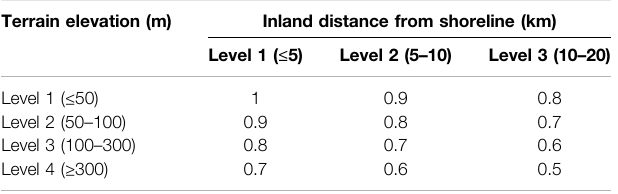
TABLE 5 | Values of the vulnerability index for the typhoon – storm surge disaster chain. Terrain elevation (m) Inland distance from shoreline